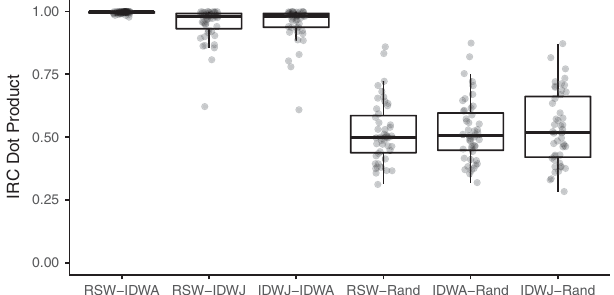
FIG. 4. Distributions of the IRC dot product values for each of the comparisons shown in Fig. 3. The RSW-IDWA comparison has a very narrow distribution near unity. The RSW-IDWJ and IDWJ-IDWA distributions are very similar and lower than RSW- IDWA. Each comparison to a simulated dataset of random responses has a distribution that is noticeably lower than any of the comparisons between real